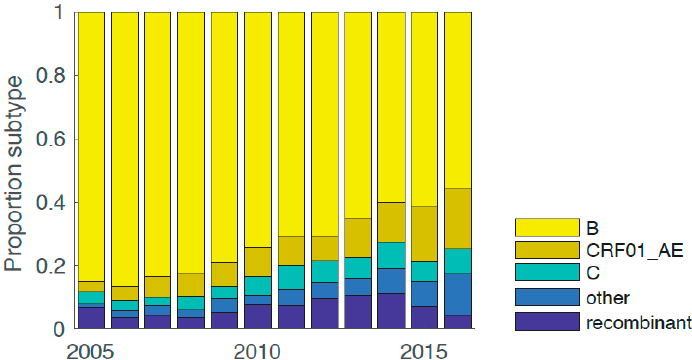
Figure 1. Changes in HIV-1 subtypes and circulating recombinant form 01_AE (CRF01_AE)_demographics over time. The proportion of subtypes is mapped across different years. Subtype B = yellow, subtype CRF01_AE = olive, subtype C = dark cyan, other non-recombinant subtypes = steel, and recombinants = blue.